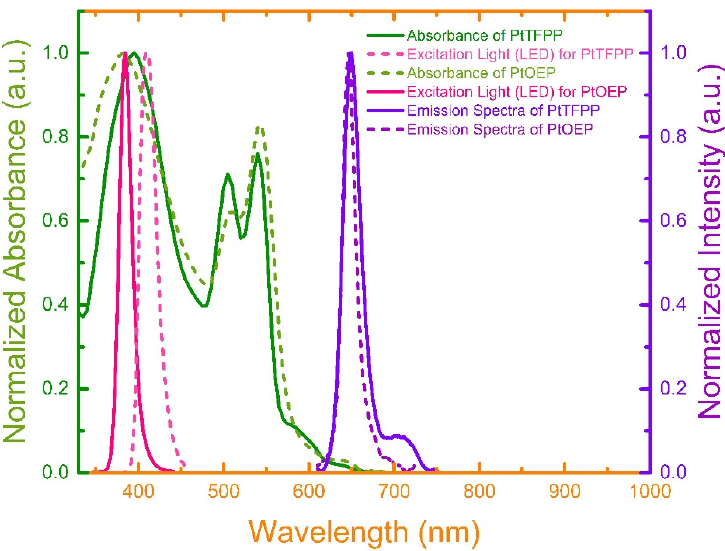
Figure 4. Absorption, emission, and excitation light (LED) spectra for PtTFPP and PtOEP